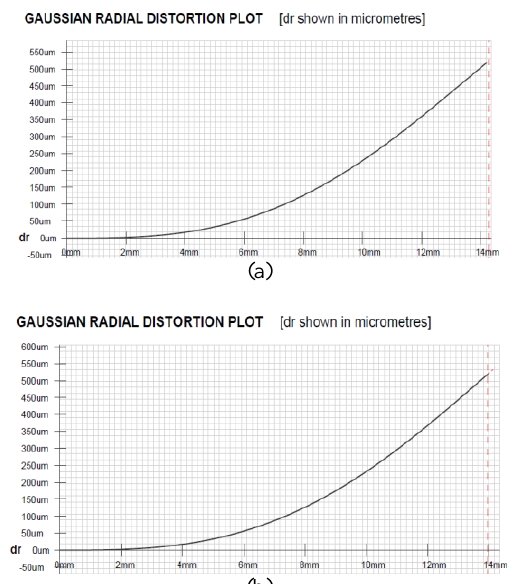
Figure 7. Radial distortion plots showing the distortion (Y-axis, µm) as a function of distance (X-axis, mm) from the principal point for results of camera calibration obtained from (a) Cage and (b) Box. The plots are obtained from Australis software